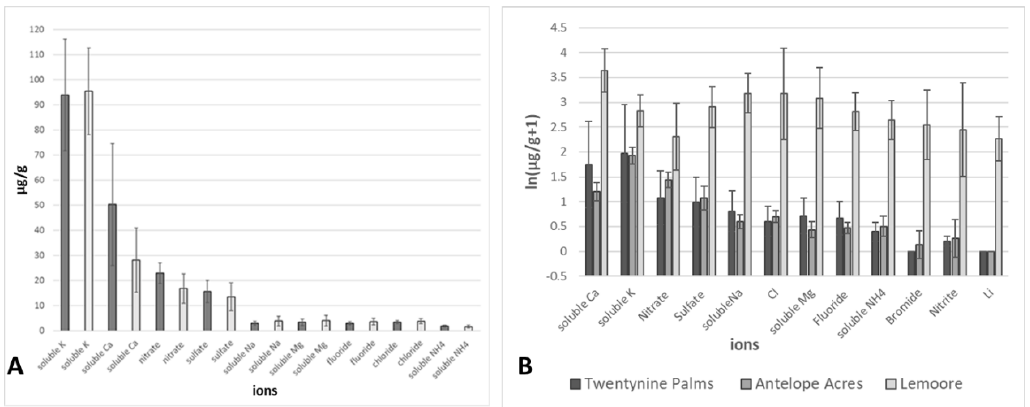
Figure 9. ( A ) Soil ion composition was not statistically different in soils where DNA of Coccidioides was detected (dark grey bars) and where DNA of the pathogen was not detected (light grey bars). ( B ) Results of soil ion analysis for selected Coccidioides DNA-positive and -negative samples form Twentynine Palms, Antelope Acres, and Lemoore (data: all sites combined: NAS Lemoore, Antelope Acres (west of EAFB), and MCAGCC Twentynine Palms, n = 41).